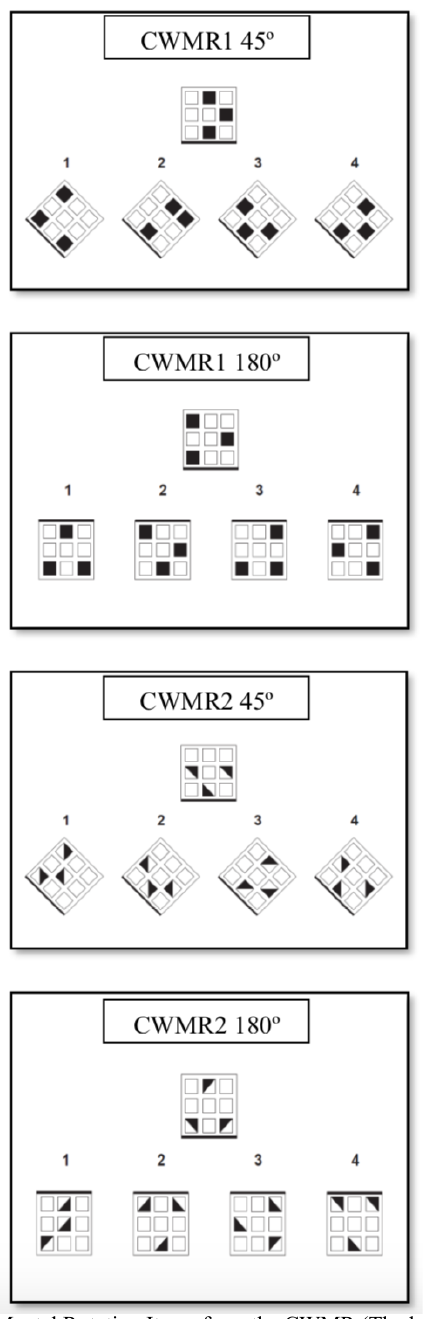
Figure 1. Mental Rotation Items from the CWMR (The heavy black line in each square is in red color in the test. The correct answers are 4, 4, 4, and 2,